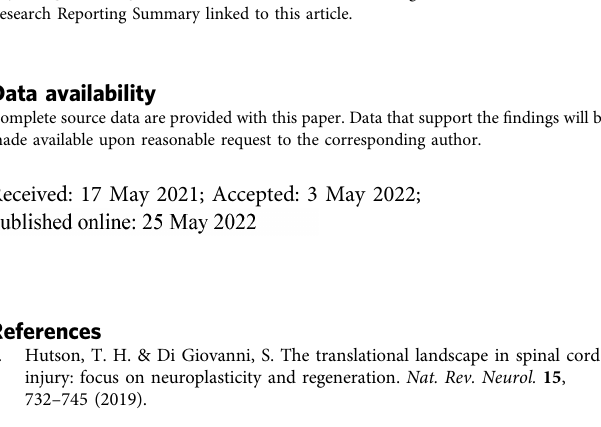
Figure design . Figures were designed using GIMP 2.10.22 and Biorender (with full licence to publish). Reporting summary . Further information on research design is available in the Nature Research Reporting Summary linked to this